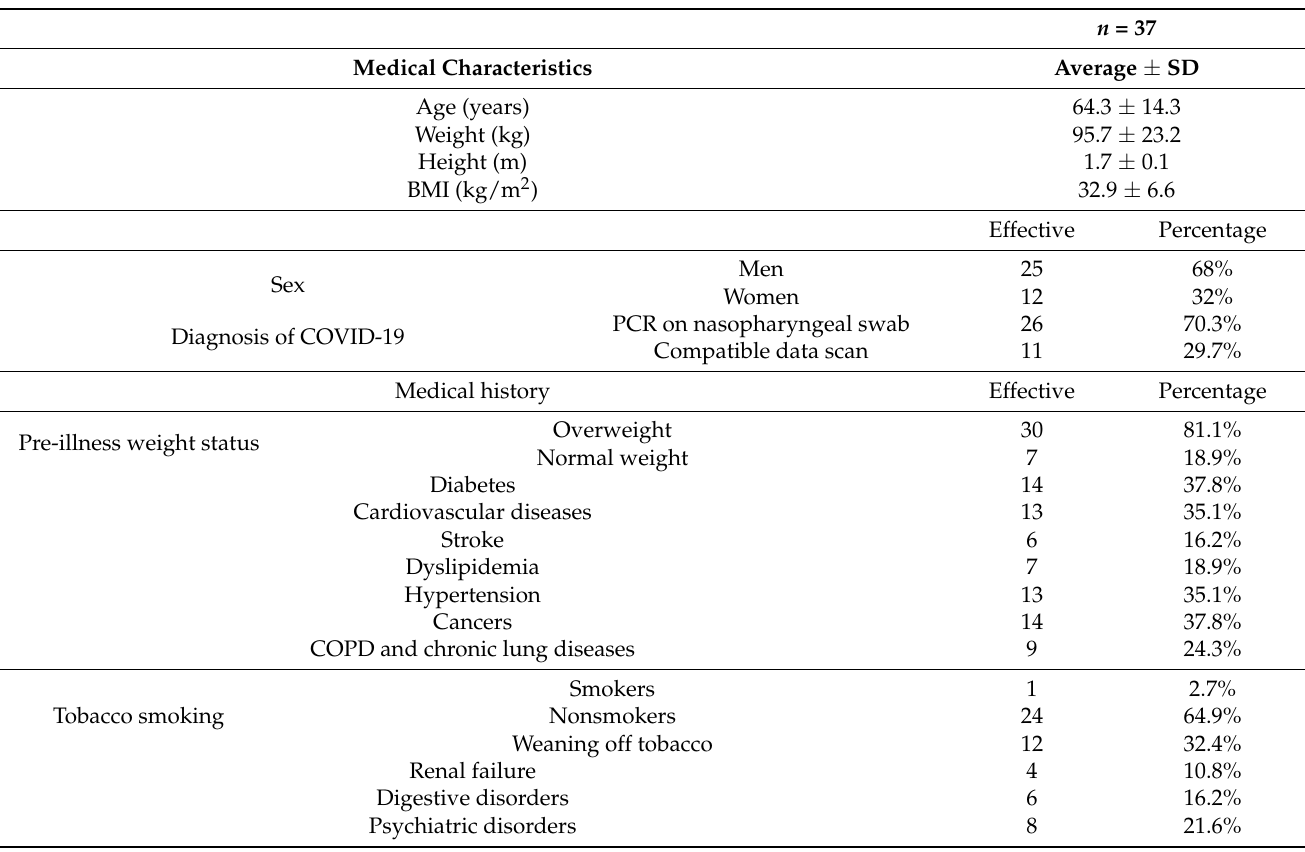
Table 1. Population characteristics.